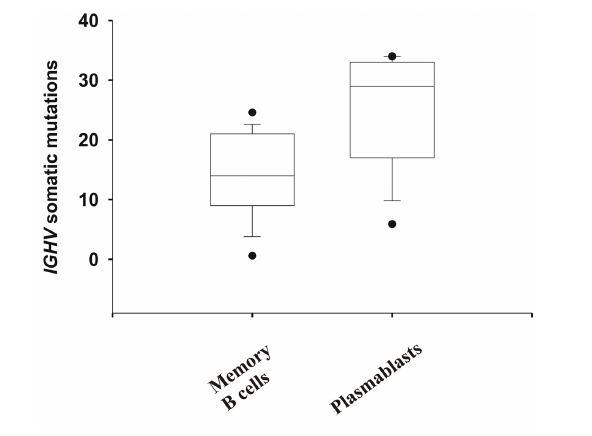
FIGURE 6 | Evidence that most mAbs originated from memory B cells that were activated by pdmH1N1. Shown are the number of somatic mutations in IGHV genes of mAbs generated from PB and memory B cells. Whiskers show the 5/95th percentile. Mann–Whitney Rank SumTest of the number of somatic mutations in IGHV genes of mAbs generated from memory B cells ( N = 23) versus PB ( N = 25) demonstrates a significant difference ( p < 0.001). Note that more than 50% of the mAbs generated from PB (which all but one cross-reacted with seasonal influenza vaccine) exhibited IGHV genes with more than 10% of their nucleotides mutated ( > 28 mutations), with the median number of mutations being